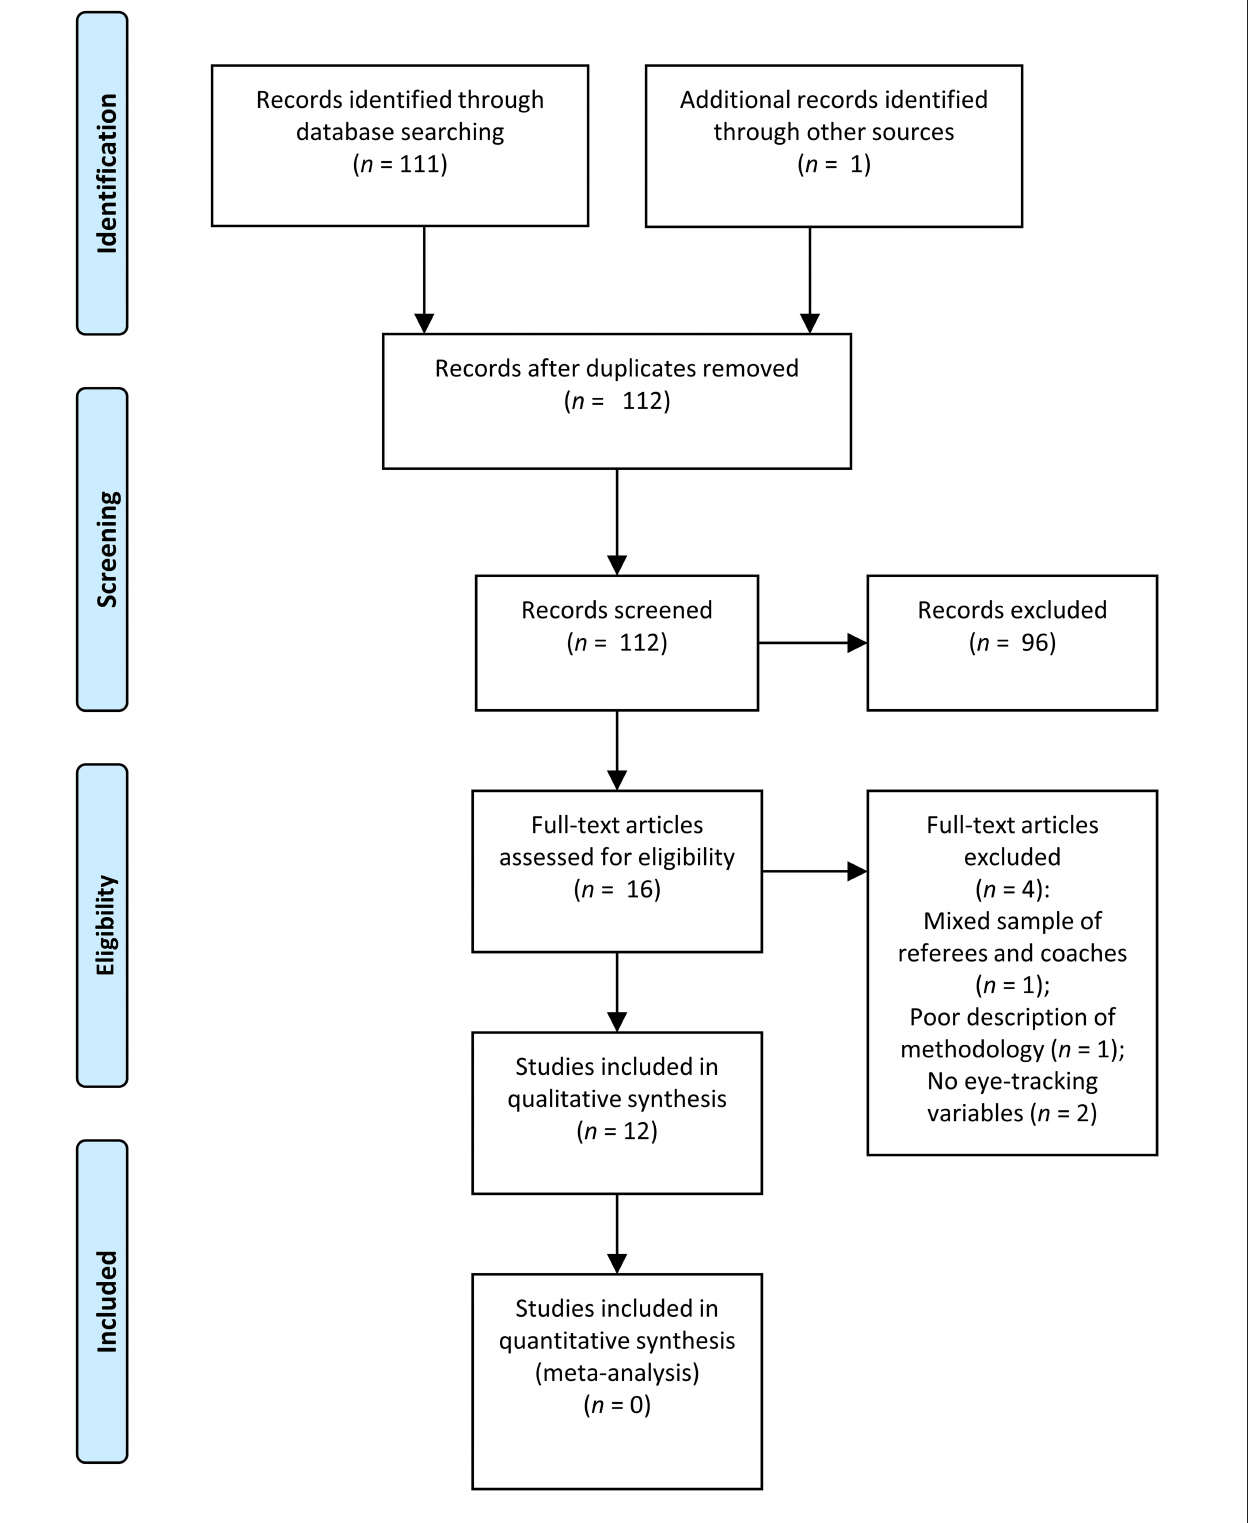
FIGURE 1 | PRISMA flow diagram of the article selection process.